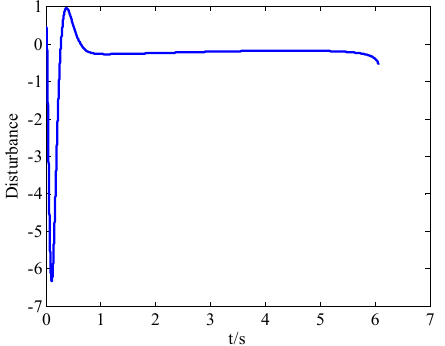
Figure 14. Projectile disturbance in real time. Sensors 2018 , 18 , x FOR PEER REVIEW